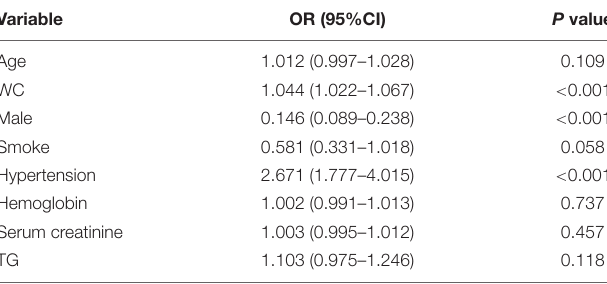
TABLE 2 | Association between serum uric acid and cardiovascular risk factors.